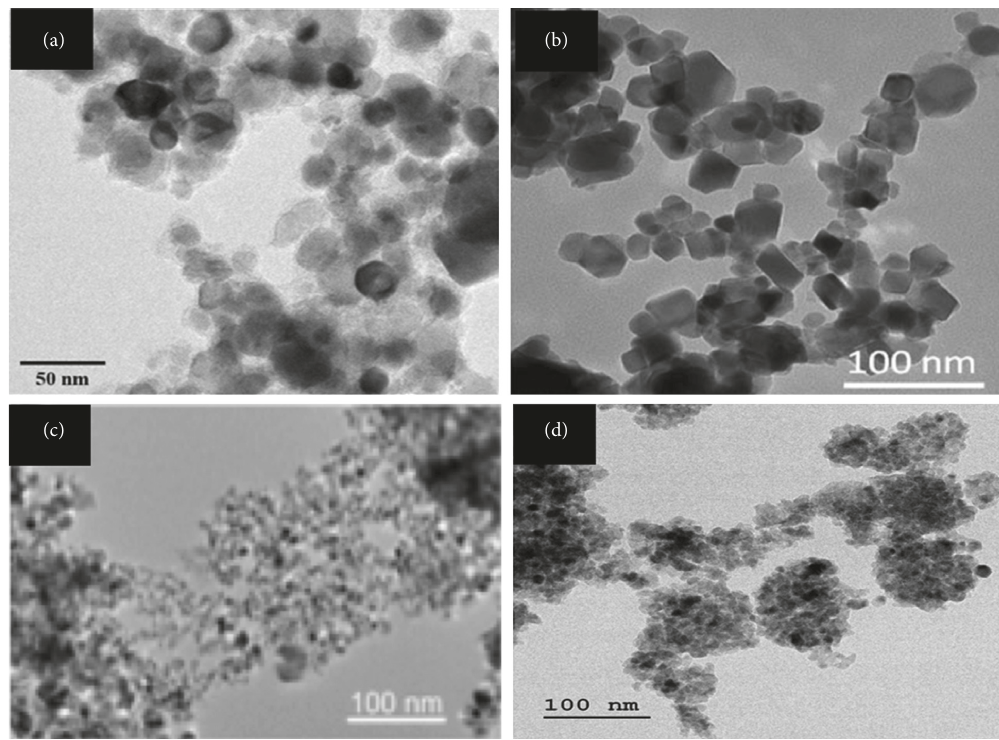
Figure 5: TEM images of (a) NiO NPs [136], (b) Co 3 O 4 NPs [98], (c) Fe 2 O 3 NPs [103], and (d) TiO 2